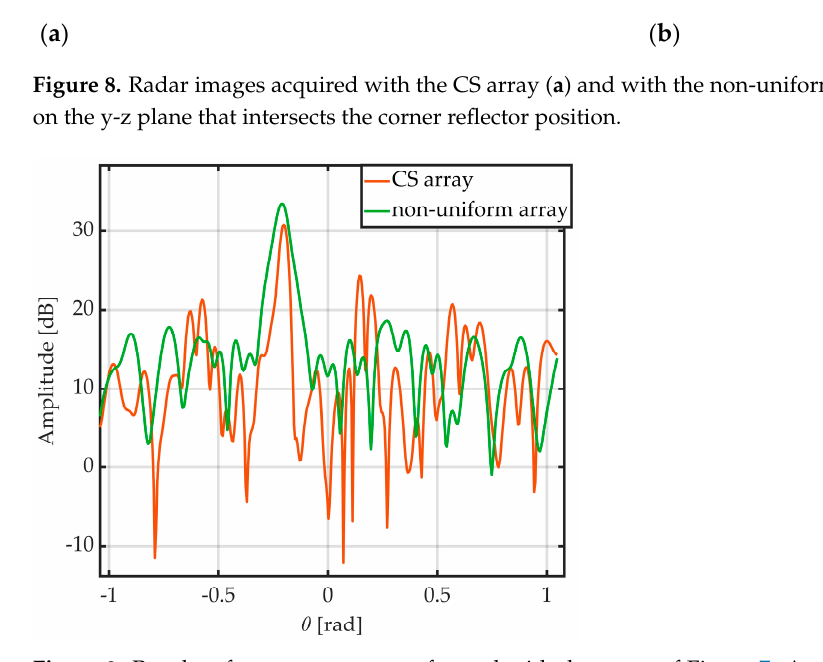
Figure 9. Results of measurements performed with the setup of Figure 7. Amplitude profile as a